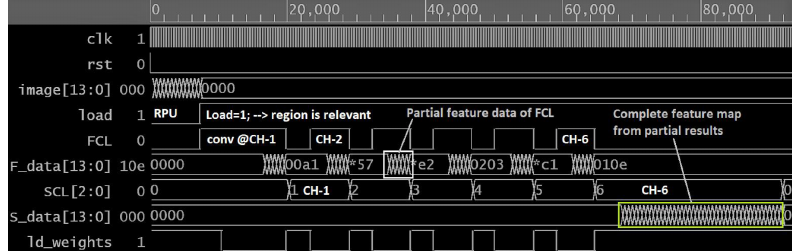
Figure 12. Simulation Result of